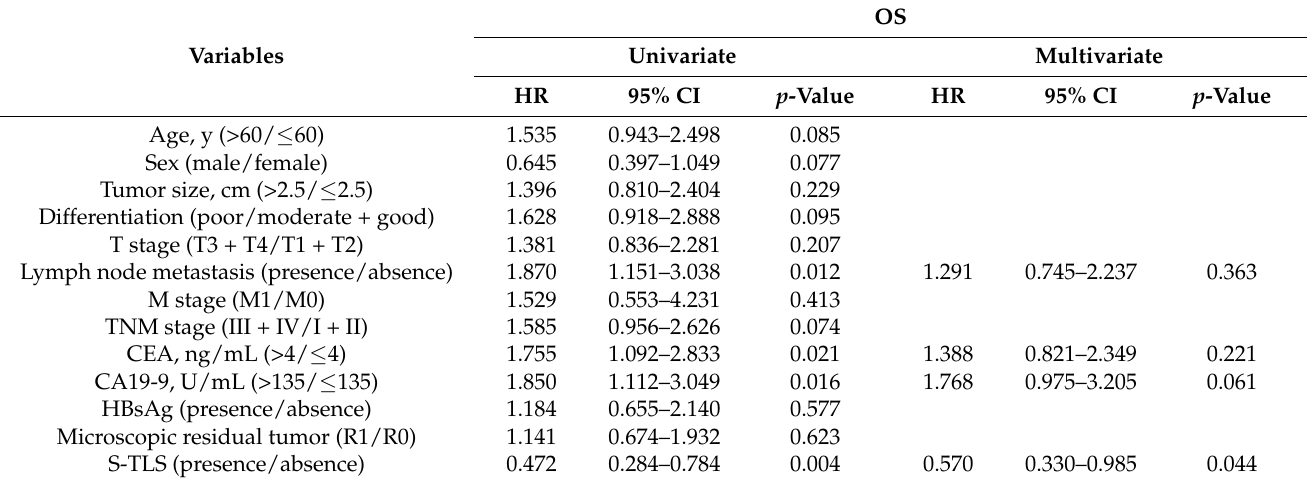
Table 3. Univariate and multivariate analyses of overall